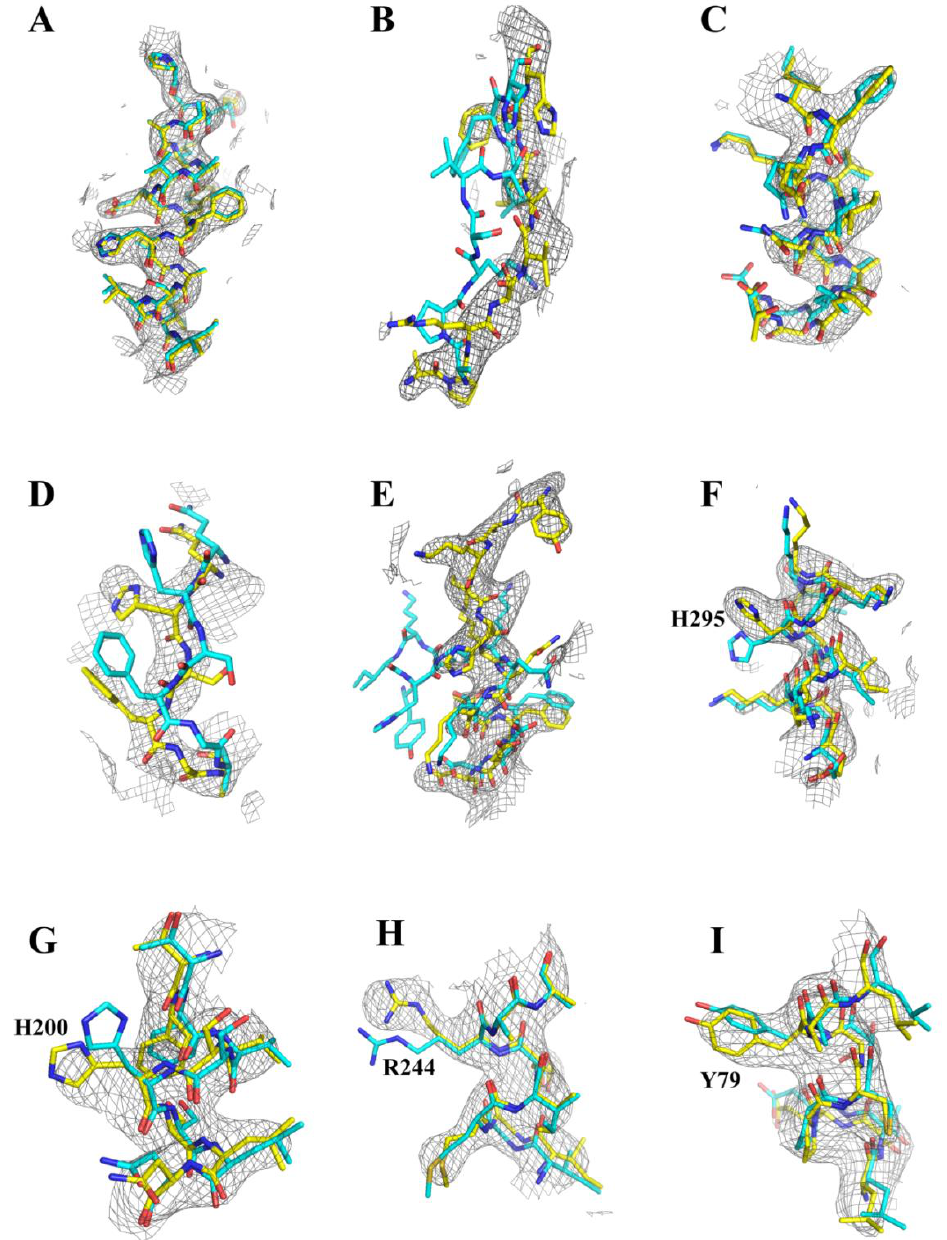
Figure 2. Structural comparison of the unmodified AF2 model against the fully refined B318L crystal structure in some representative regions with the final 2Fo-Fc electron density map overlaid. The fully refined B318L crystal structure and AF2 model are colored yellow and cyan, respectively. The 2Fo-Fc electron density map is contoured at 1.0 σ and represented as a gray mesh. ( A ) A standard α -helix region (P111-I128) showing a nearly excellent agreement between the two models. ( B ) The N-terminus (A31-H39) showing significant backbone deviations. ( C ) The C-terminal region (I307-T318) presenting some minor main-chain displacements. ( D ) The connecting loop region (Q102-A107) exhibiting both main-chain and side-chain discrepancies. ( E ) A highly flexible region (Y270-D282) at the periphery of a piece of the broken structural fragment (H262-N269) displaying completely different conformations. ( F – I ) Some selected local regions sharing the same C α atomic coordinates while adopting remarkably different side-chain orientations with the key residues labeled accordingly. The pLDDT scores for these four residues are 97.3 (H295), 97.9 (H200), 98.2 (R244), and 97.3 (Y79),